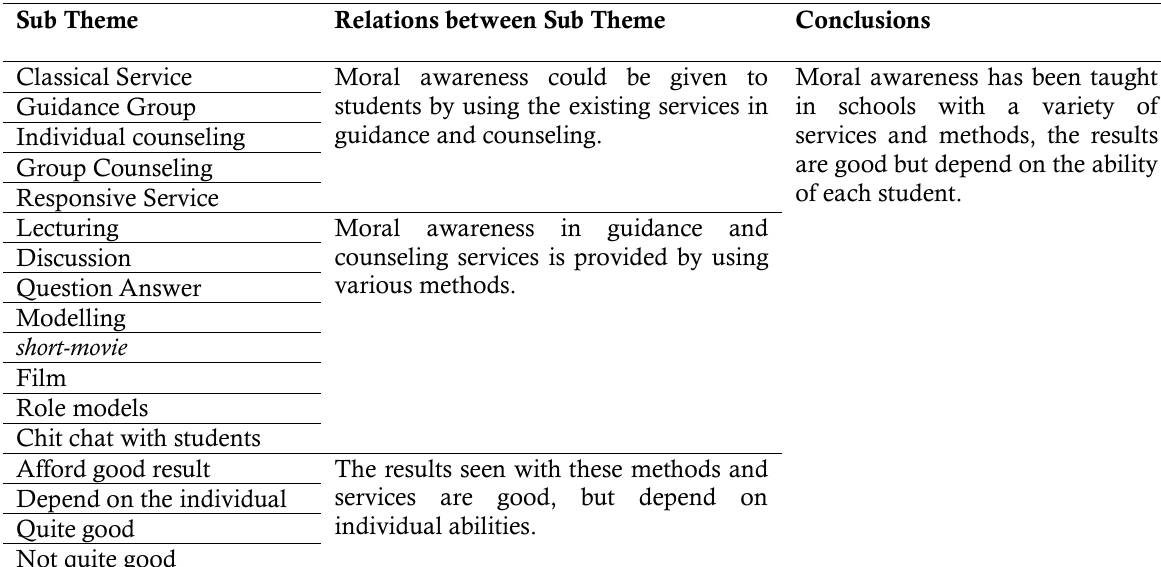
Table 2. Strategies used to increase moral awareness and